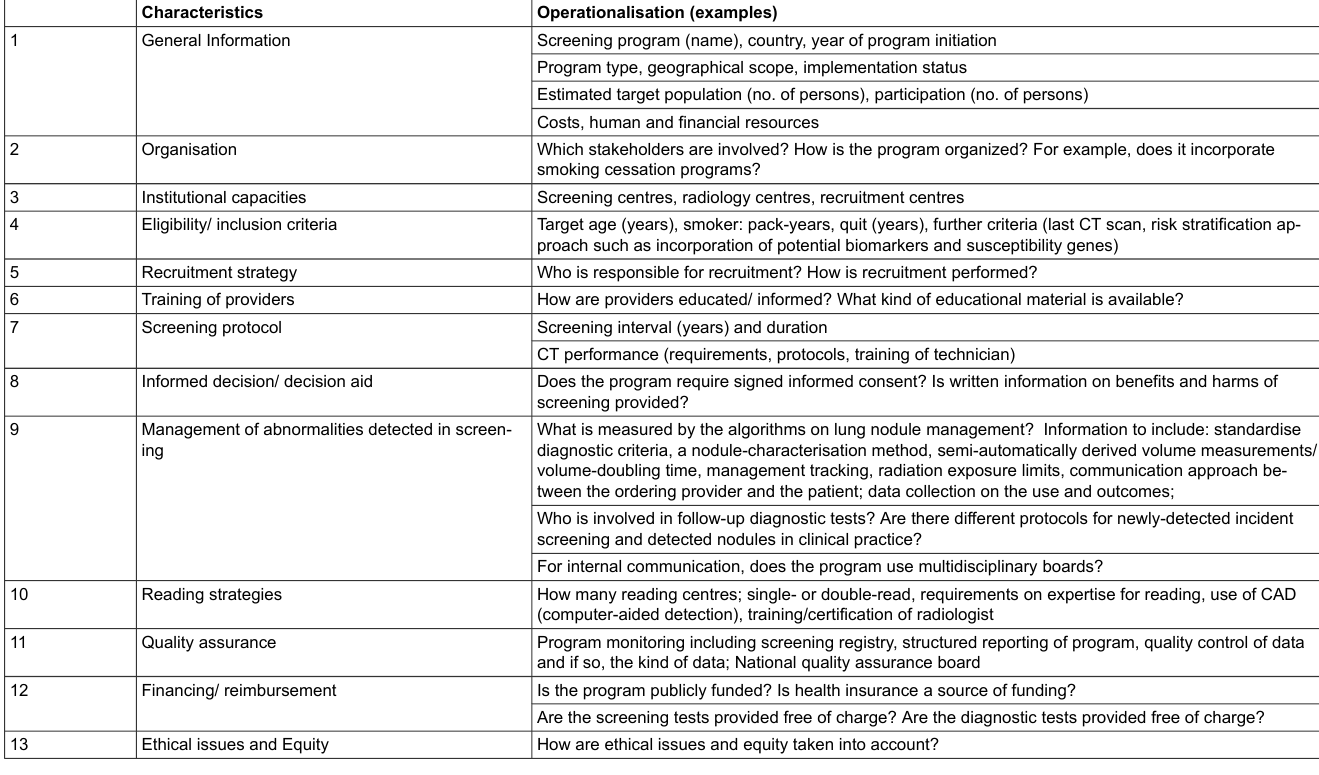
Table 1: Characteristics covered in the stakeholder interviews.